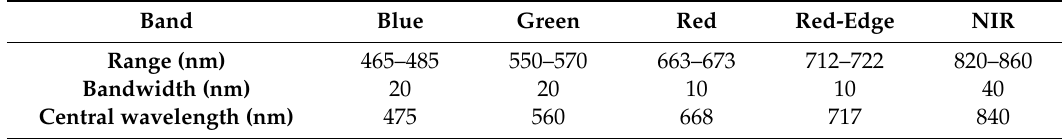
Table 2. MicaSense RedEdge band